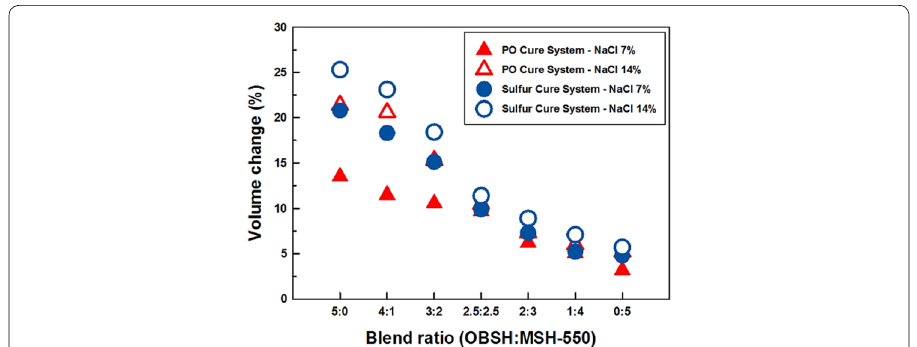
Fig. 8 Salt‑water resistance of bio‑EPDM foam depending on the mixing ratio of blowing